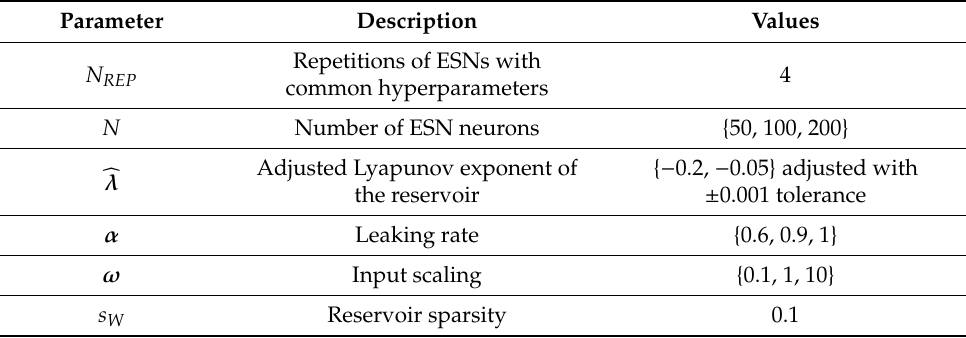
Table 2. Parameters of echo state networks (ESNs) used in models combined in an ensemble.